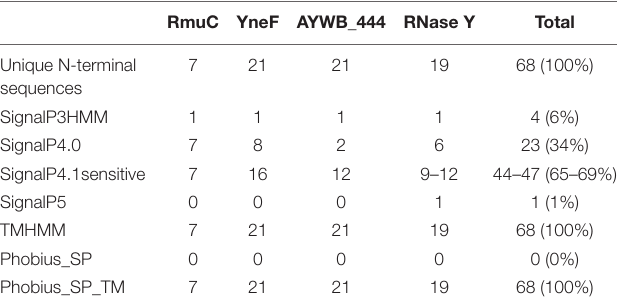
TABLE 7 | Count of positive signal peptide predictions for the RmuC , YneF , AYWB_444 , RNaseY gene families.